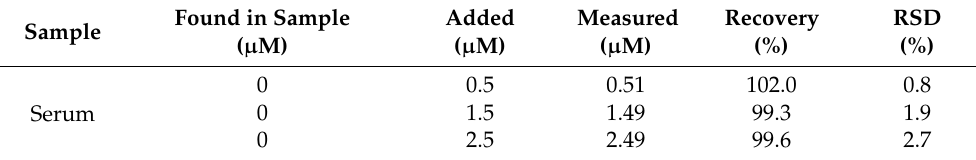
Table 4. Determination of AP in bovine